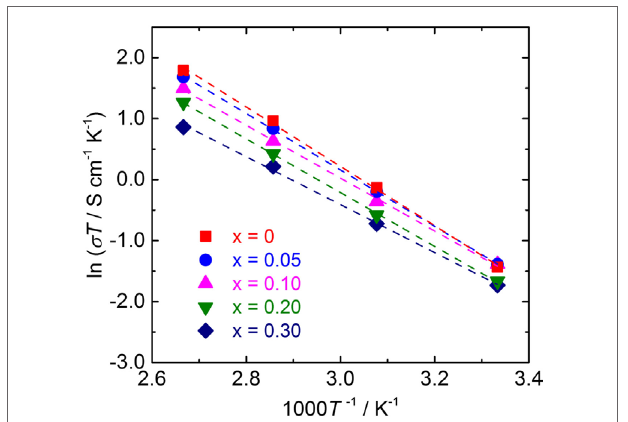
FigUre 9 | a cyclic voltammogram of llBZT with Ba contents x = 0.20 measured at a scanning rate of 0.2 mV s − 1 at 27°c